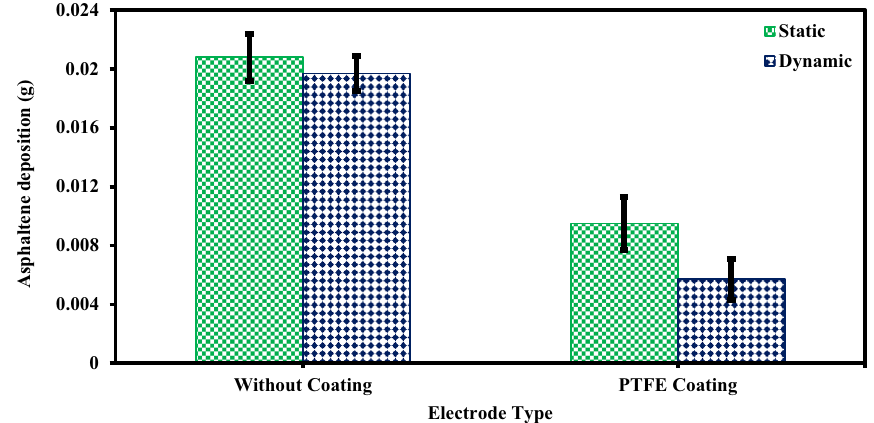
Figure 5. Comparison of asphaltene deposition on uncoated and PTFE coated electrodes after 300 s of exposure to electric filed and for asphaltene concentration of 2000 ppm at ambient pressure and temperature.